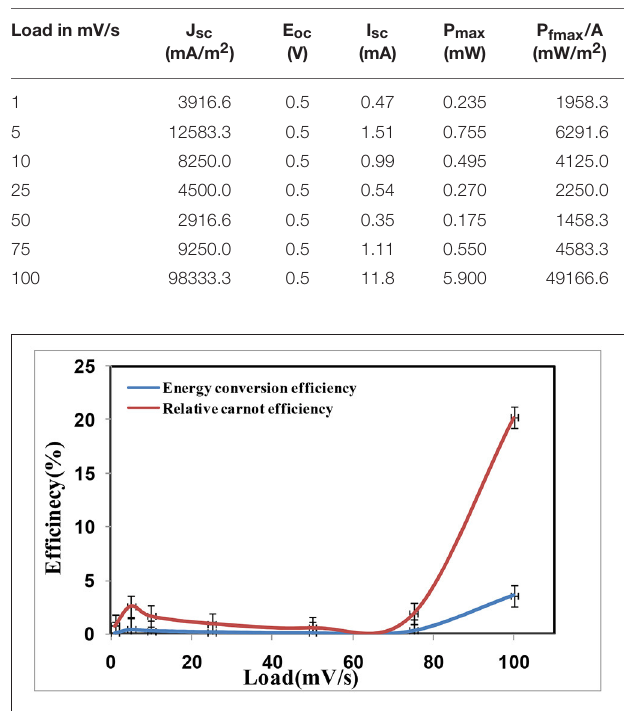
TABLE 1 | Power and current density values of the device at 1 T = 60 ◦ C.